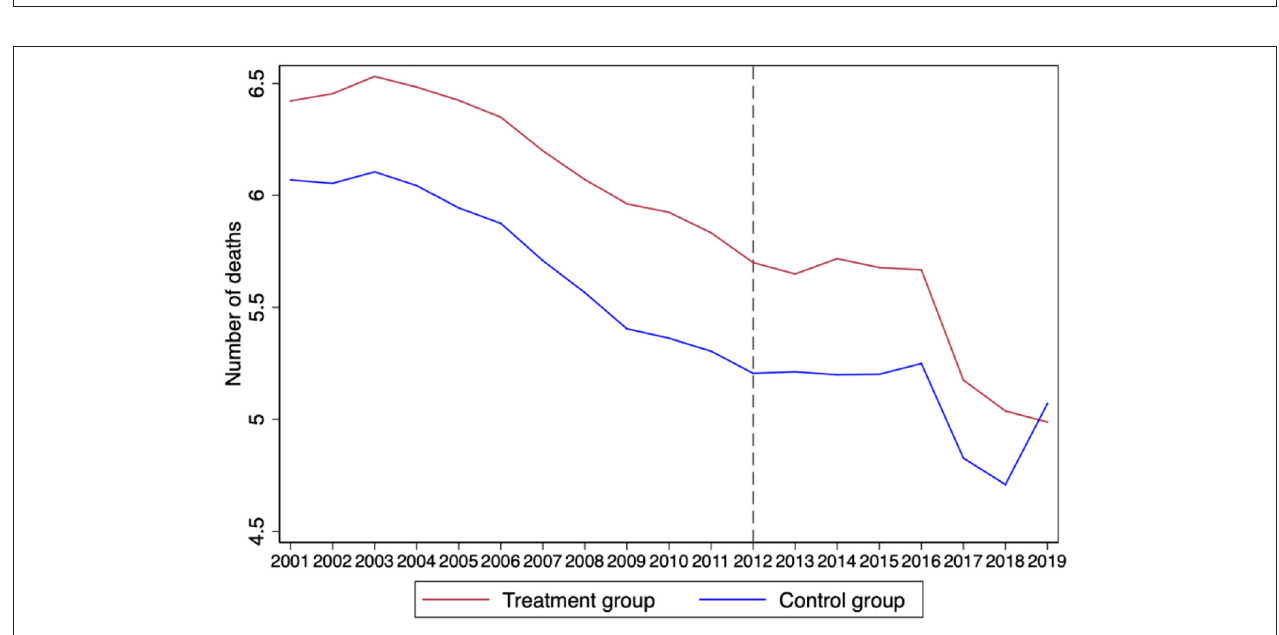
FIGURE 1 | The result of parallel trend (death rate).